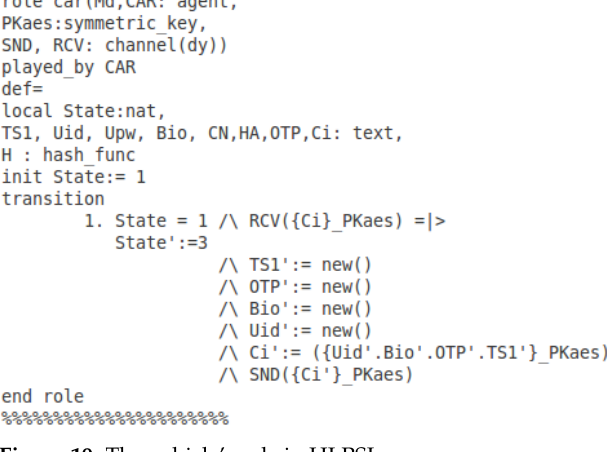
Figure 19. The vehicle’s role in